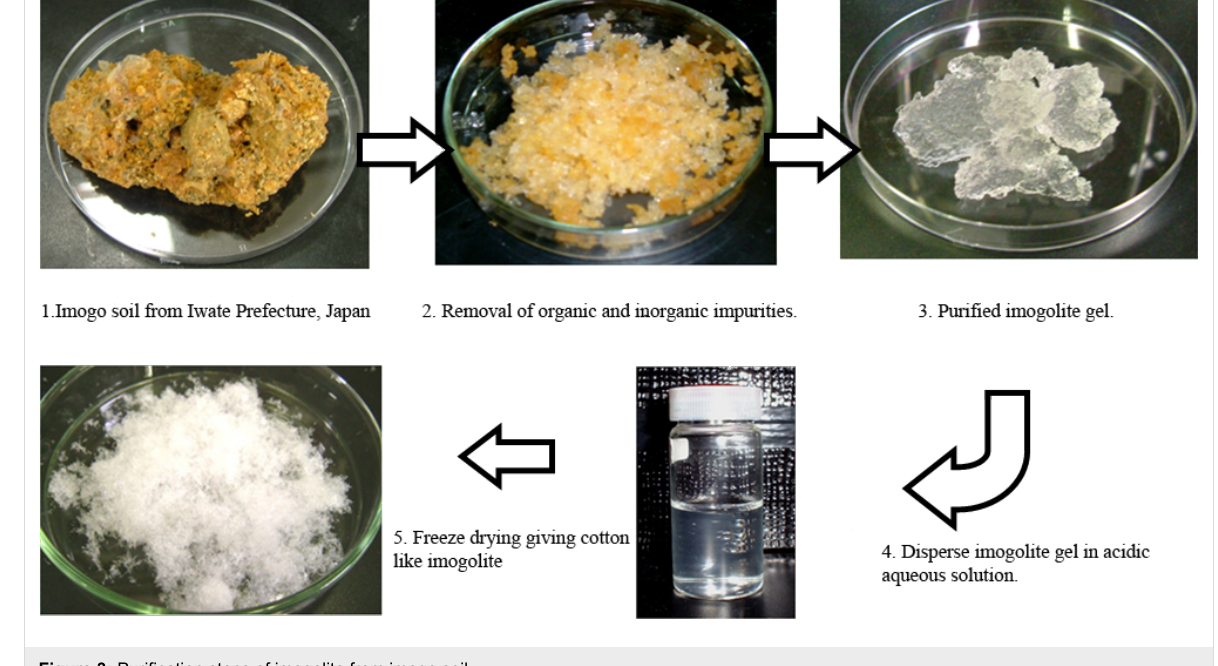
Figure 3: Purification steps of imogolite from imogo soil.